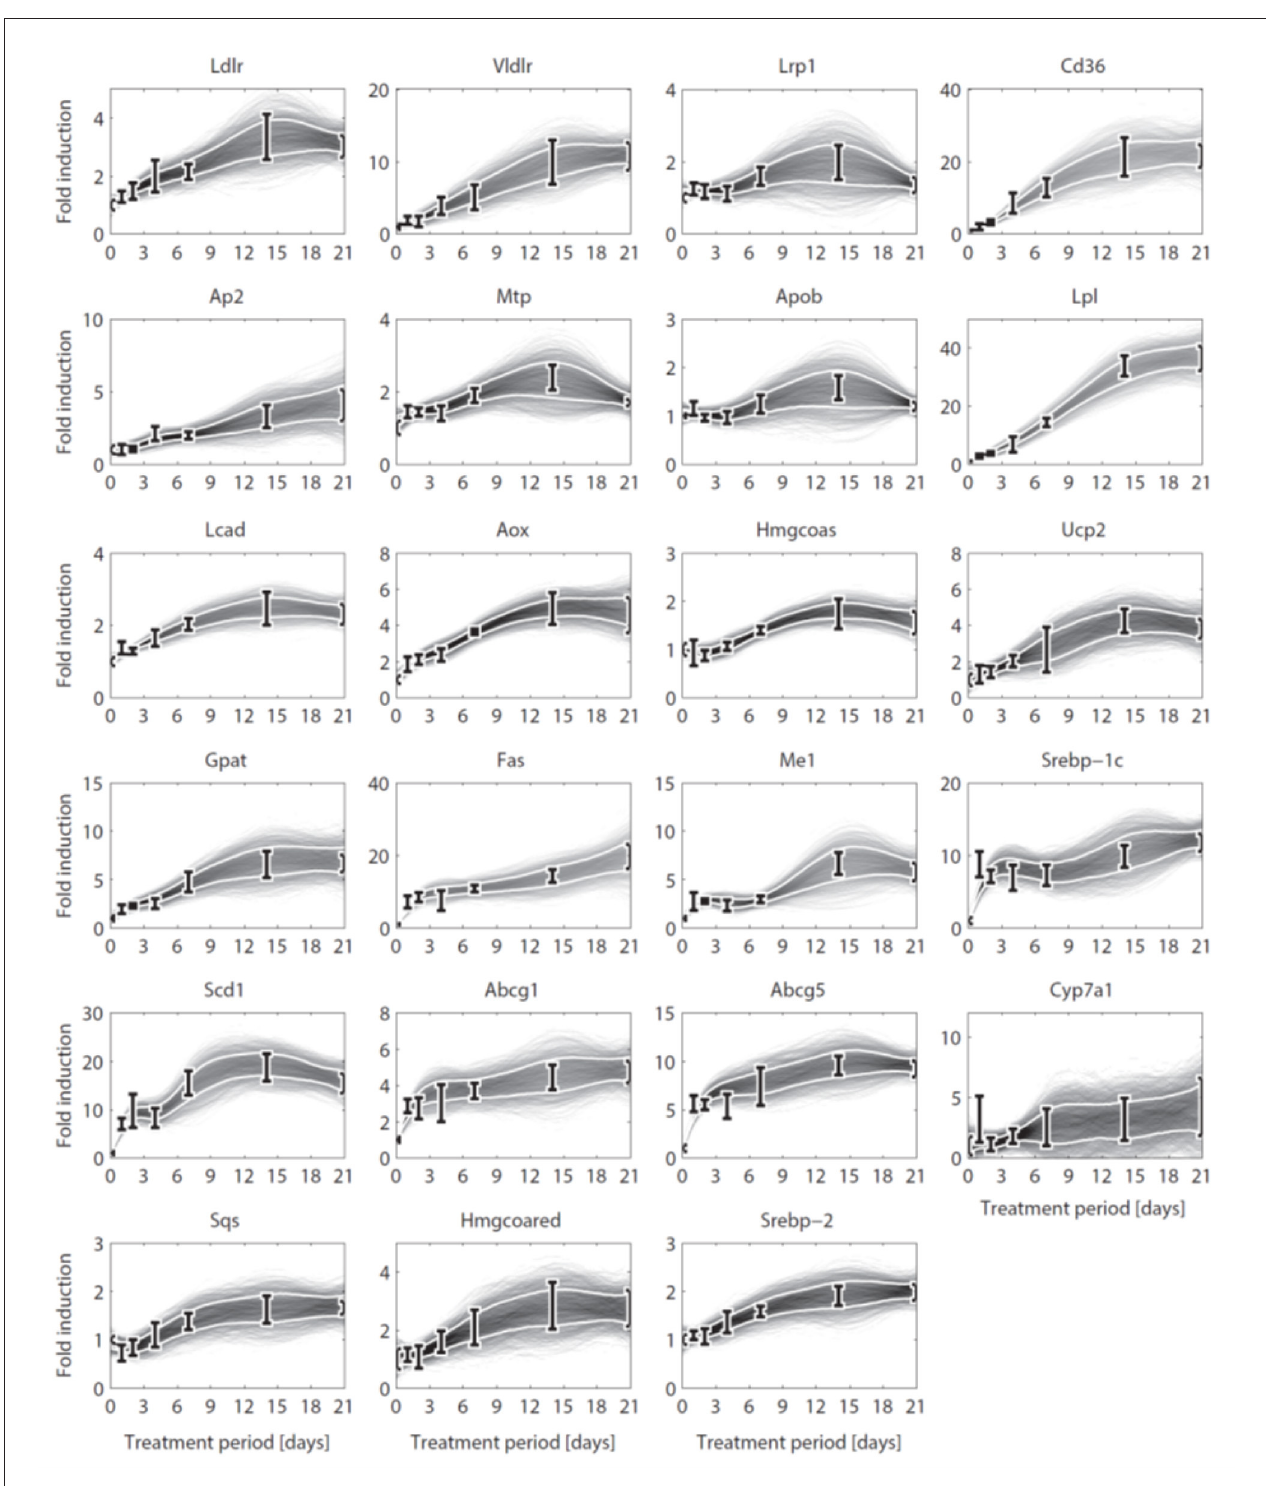
FIGURE 3 | Gene expression data and interpolants. Temporal expression data for 23 genes and 2D histograms of the corresponding cubic splines that were used as input for ADAPT (included in χ 2 g and χ 2 g ). The experimental data is represented as means ± standard deviations ( N = 5-6). The white lines enclose the central 67 % of 1 2 the interpolant density at each time point. (see Table 3 for the gene names).